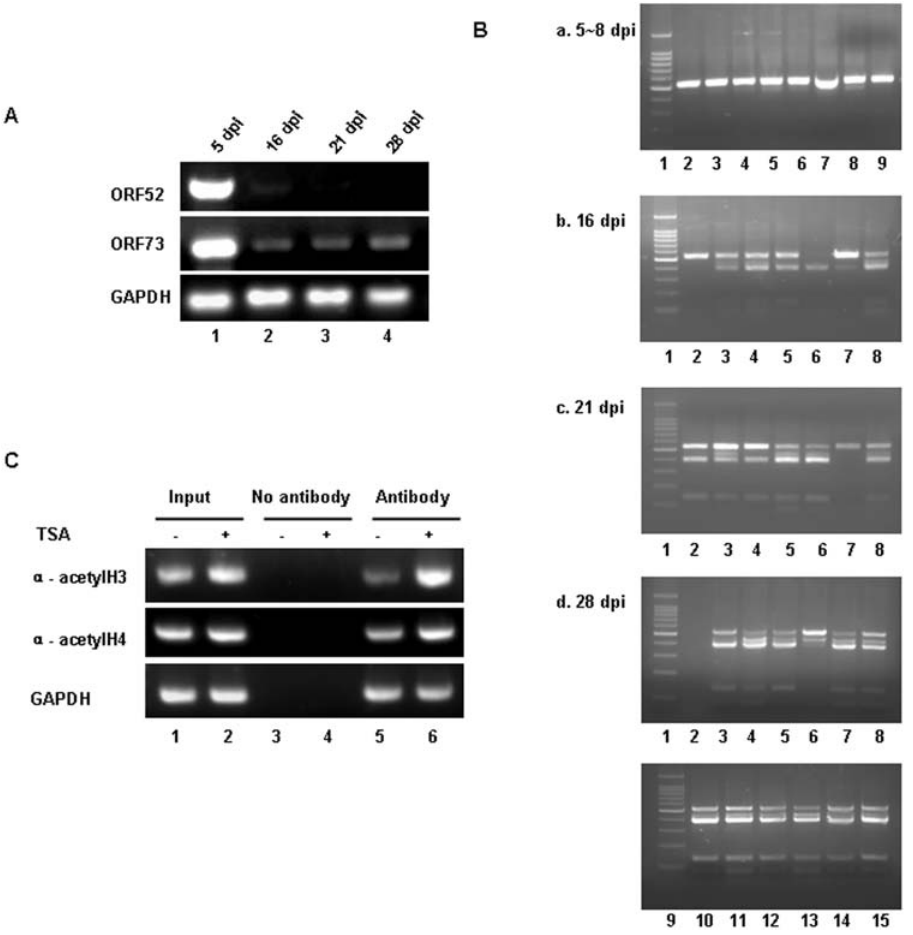
Figure 7. Analysis of methylation and acetylation status of the RTA promoter invivo . (A) RT-PCR detection of ORF52 and ORF73 expression. Infected tissues were prepared mice at 5, 16, 21 and 28 dpi and mRNA extracted. The coding sequences for ORF52 and ORF73 were RT- PCR amplified and separated on a 2% agarose gel. (B) COBRA of methylation status of RTA promoter. DNAs were extracted from infected tissue at 5, 8, 16, 21 or 28 dpi respectively, bisulfite treated, amplified by PCR, digested with Taq a | and separated on a 2% agarose gel. (C) TSA treatment of MHV-68 latently infected mice. At 28 dpi, MHV-68 infected BALB/C mice were administrated with TSA by subcutaneous injection in the groin (2.4 mg/kg). Five hrs post-induction, ChIP assay were used to detect histones H3 and H4 acetylation level at the RTA